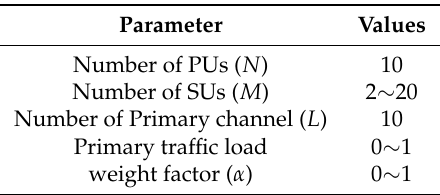
Table 6. Simulation